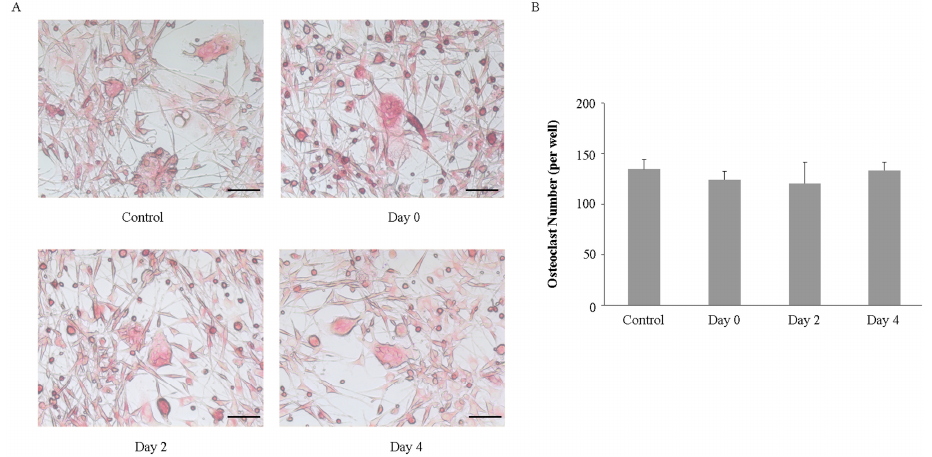
Figure 3. Imipramine did not inhibit RANKL-mediated osteoclast formation. ( A ) Non-adherent bone marrow cells were induced by RANKL plus M-CSF for 6 days to generate mature osteoclasts in the absence of imipramine (control group) or in the presence of imipramine (10 µmol/L) at the beginning of the cell culture (Day 0 group), 2 days after the cell culture (Day 2 group), or 4 days after the cell culture (Day 4 group). Cells were fixed and stained for TRAP; ( B ) The numbers of TRAP staining positive cells were calculated. Each bar represents the mean ± standard deviation in a 24-wellplate ( n = 3). Bar, 100 µm.